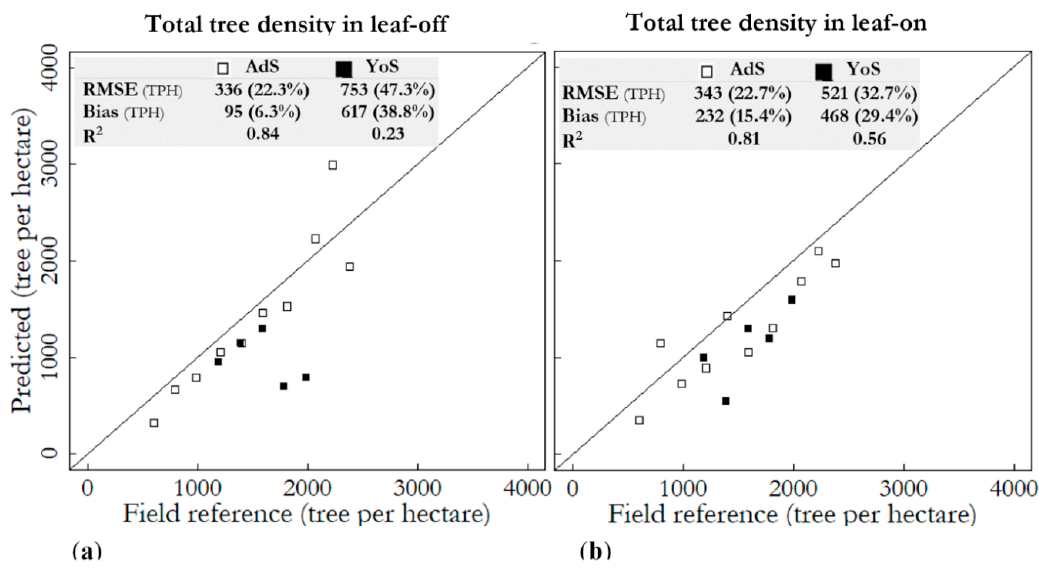
Figure 3. Total tree density (unit: TPH) in leaf-off ( a ) and leaf-on ( b ) conditions, separating plots in advanced seedling stand (AdS) and plots in young seedling stand (YoS).